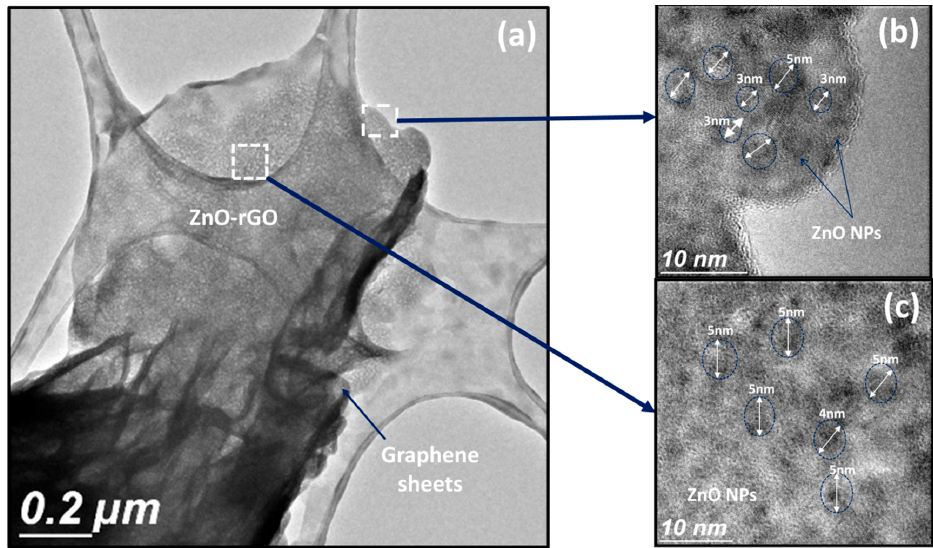
Figure 3. TEM images of ( a ) ZnO-rGO nanocomposite, ( b ) ZnO nanoparticles anchored on the edge of graphene sheets and ( c ) ZnO nanoparticles anchored into graphene sheets.